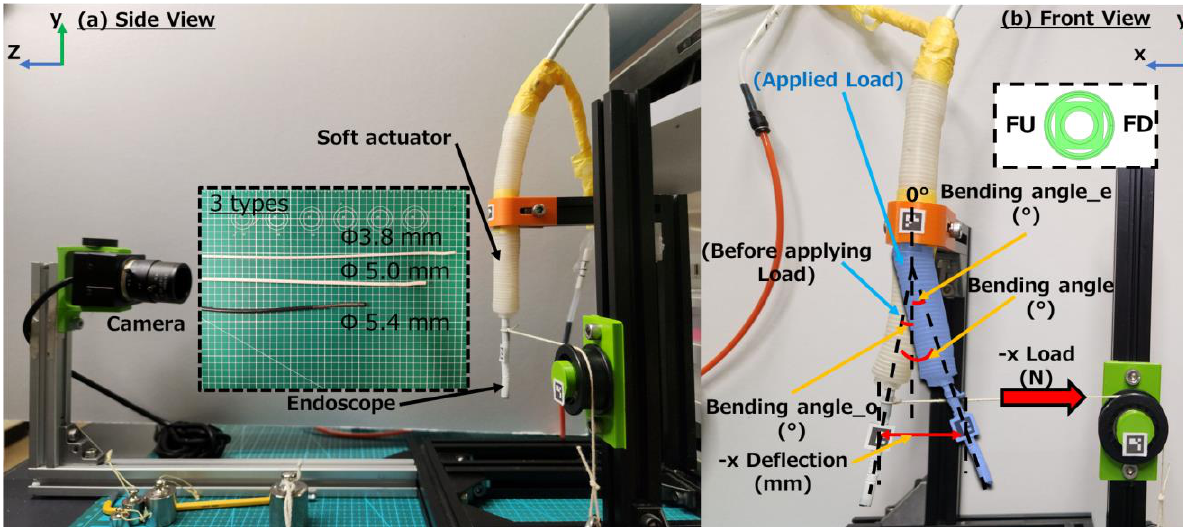
Figure 1. Measurement method of soft actuator ( a ) side view, ( b ) front view.